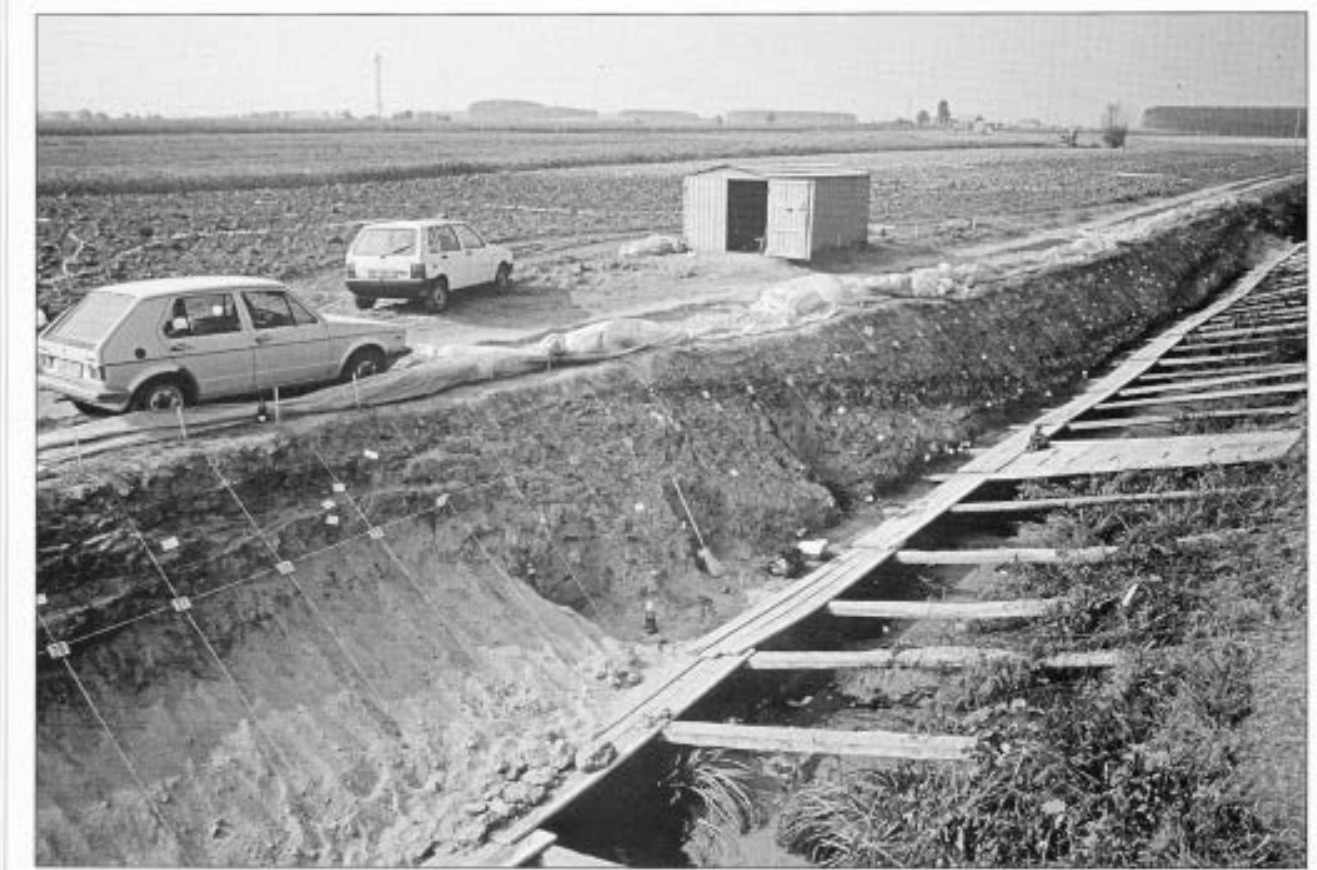
Figure 4 A section (cut by machine for field drainage) through a Bronze Age bank and ditcl1 at the site of Fabbricia dei Soci. charcoal and bone taken from stratified deposits in sections through settlement sites. The earliest site is that of Canar (Fig. 1), a so-called lake-village (palafitta) set­ tlement, established in a low-lying area, close to, or possibly built over, open water. It is assigned on typological grounds to the middle-late part of the Early Bronze